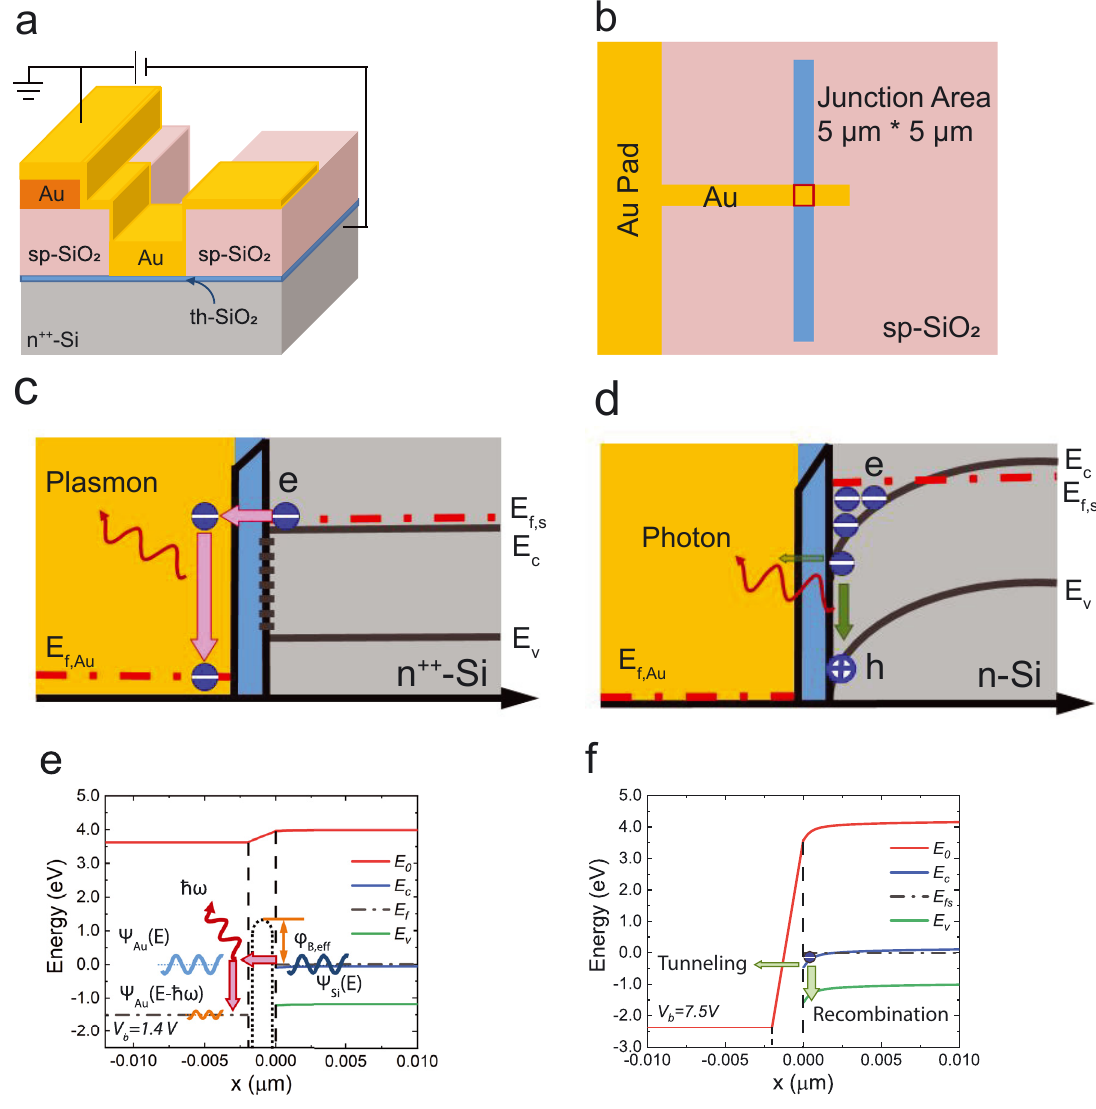
Figure 1: (a) Schematic of Au/SiO 2 /n-Si tunnel junction consisting of gold strip electrode (thickness 40 nm and width 5 μ m) on the n ++ -Si substrate (thickness ∼ 500 μ m) within a 2-nm-thick thermal SiO 2 ( “ th-SiO 2 ” ) in between. Au/SiO 2 /n-Si plasmons are excited in junction area. “ sp-SiO ” stands for sputtered oxide. (b) The top view of MIS tunnel junction (in red frame) with an area of 5 × 5 μ m. (c) A schematic of energy 2 diagram at low forward bias of Au/SiO 2 /n ++ -Si showing quantum tunneling mechanism dominating the forward current fl ow and plasmons generationoriginatingfrominelastictunneling.Theshorthorizontalblacklinesatn ++ -Si/SiO 2 interfacestandforbandtailstatesinthesilicon bandgap. (d) A schematic of Au/SiO 2 /n-Si to show the mechanismof light emissioncausedby electron – holerecombination in silicon when a largepositivevoltageisappliedonAu.(e)CalculatedenergybanddiagramoftheMIStunneljunctionwithapositivevoltagebias V b =1.4Von top electrodeAu for caseof n ++ Si. The red arrow indicates an inelastic electrontunneling process resultingin surface plasmonexcitation with the energy of ℏ ω (wiggly arrow). The tunneling barrier height is φ B,eff . (f). Calculated energy banddiagram of MIS junction with a large positive voltage bias V b = 7.5 V on top electrode Au. A thin green horizontal arrow represents a small number of electrons tunneling through SiO 2 barrier, and the thick green arrow indicates the accumulated electrons at conduction band at the n-Si/SiO 2 interface recombining with the holes at the valence